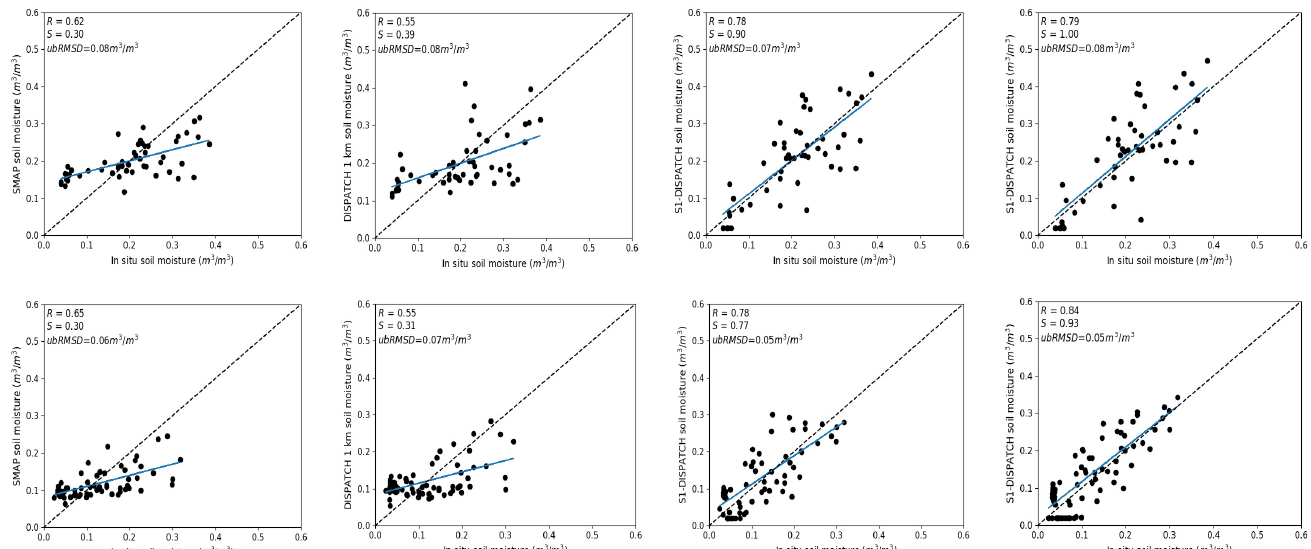
Figure 9. Scatter plots (from left to right) of the original 40 km resolution SMAP SM, the 1 km resolution DISPATCH SM, the 100 m resolution calibrated-disaggregated SM for the linear model and the 100 m resolution calibrated-disaggregated SM for the non-linear model versus in situ measurements, for Sidi Rahal ( top ) and Chichaoua ( bottom ) sites